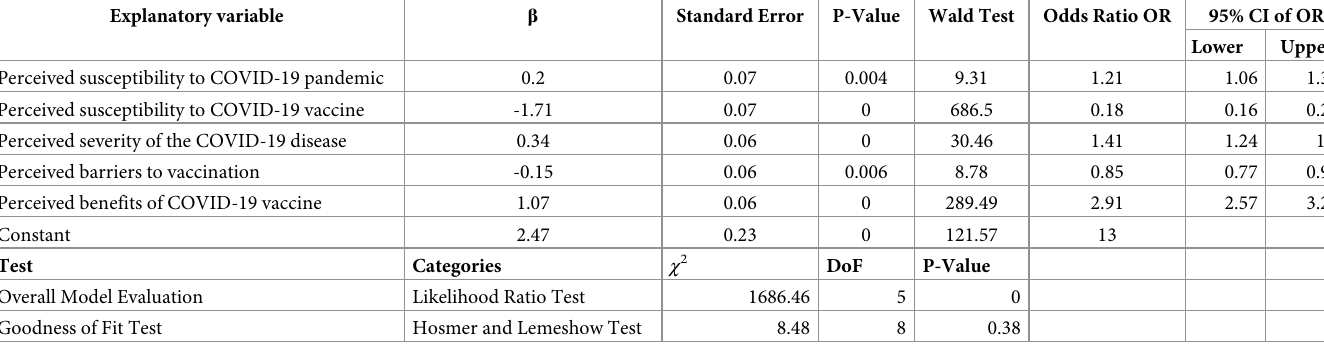
Table 3. Regression analysis—predictors of the HBM construct and COVID-19 vaccine intention.